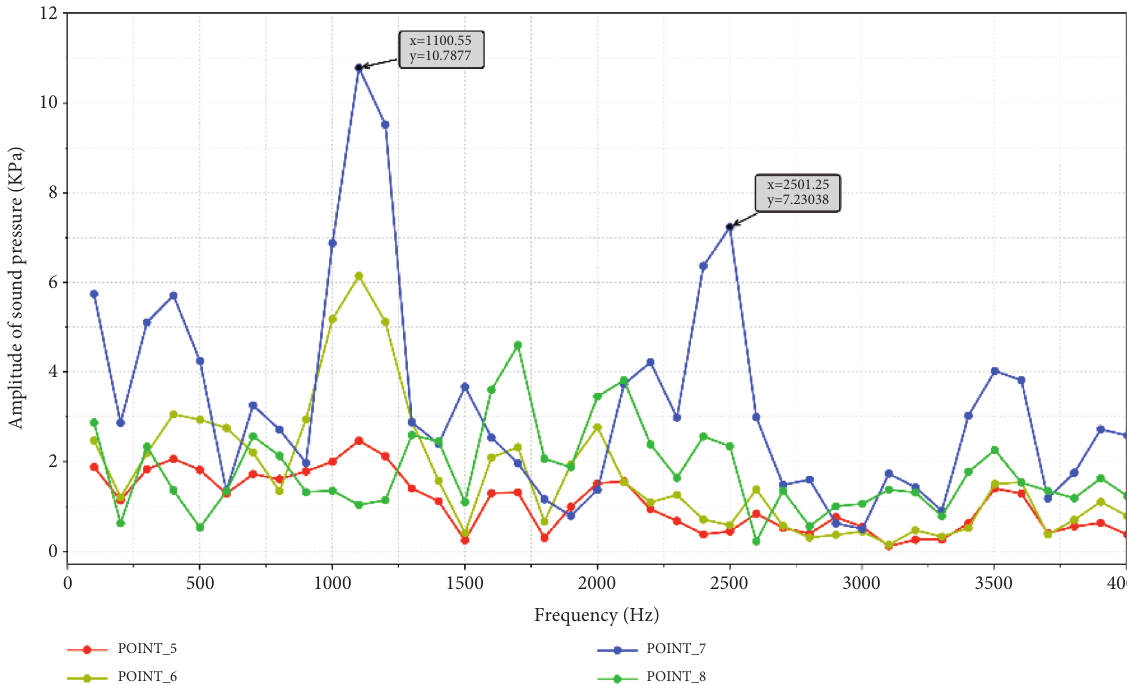
Figure 22: Frequency spectrums of P5, P6, P7, and P8.